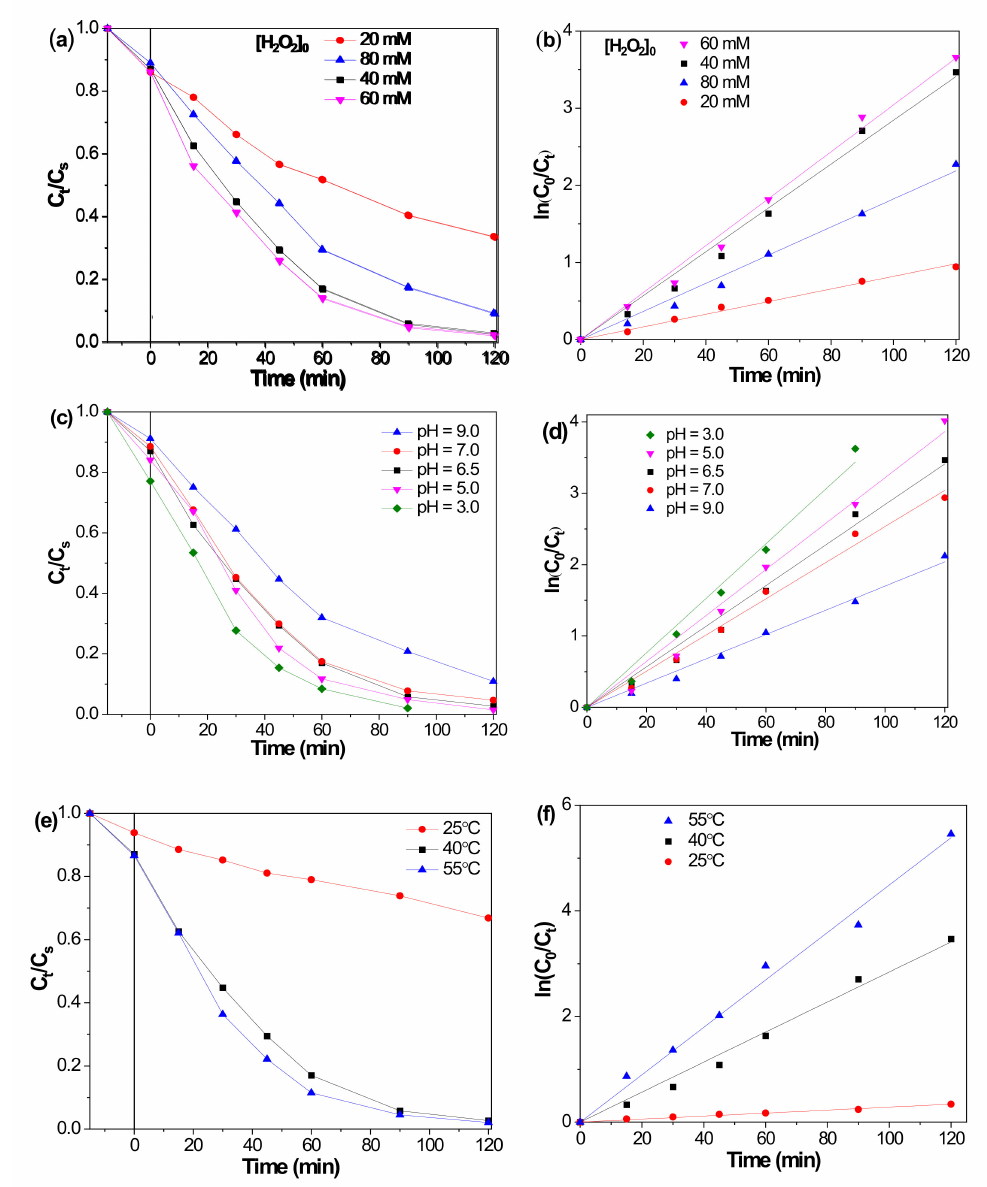
Figure 2. Effects of reaction parameters on OG decolorization with H 2 O 2 over F-Fe 3 O 4 -1. ( a , c , e ) C t /C s -time plots and ( b , d , f ) ln(C 0 /C t )-time plots. General reaction conditions: OG (0.10 mM, pH 6.5), H 2 O 2 : 40 mM, and F-Fe 3 O 4 -1: 0.5 g/L at 40 ◦ C for 2 h unless otherwise specified in the